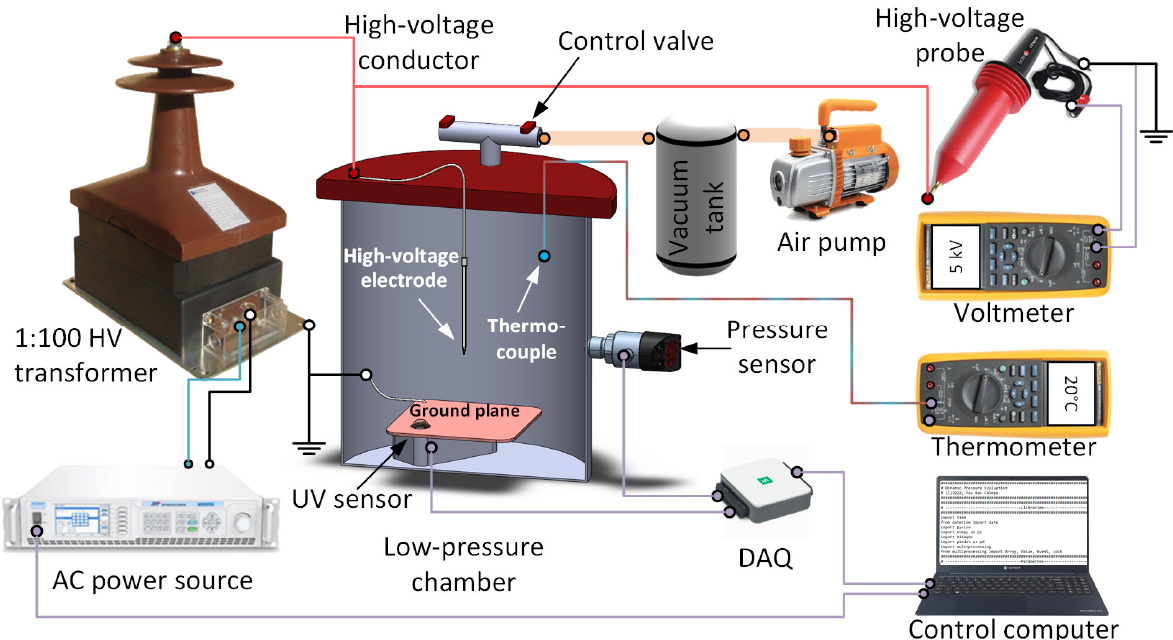
Figure 2. Sketch of the experimental setup.